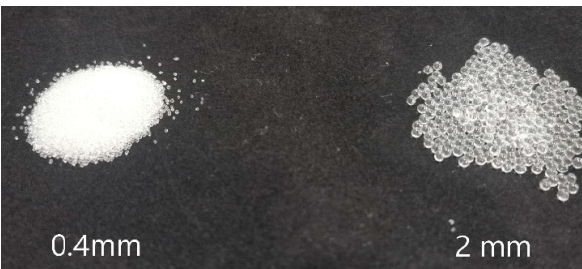
Figure 6. Particle morphology.